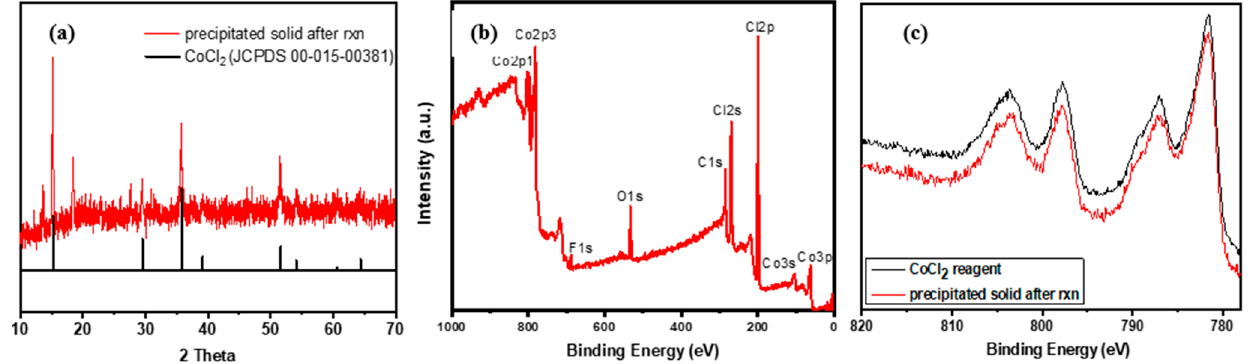
Figure 6. ( a ) Powder XRD diffractogram and XPS analysis results of ( b ) Wide scan and ( c ) Co2p of the precipitated solid collected after [Me 4 N] 2 CoCl 4 -catalyzed methane oxidation at 180 °C for 1 h.